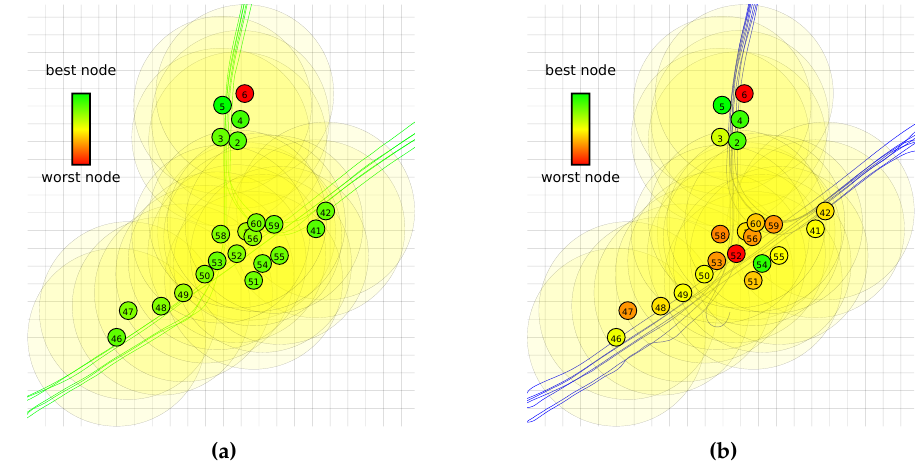
Figure 8. Spatial visualisations of performance of the network when a node is used for the offline phase for the QUEST algorithm. The grid size is 20 m. Colors are assigned on a linear relative scale from red for the worst performing node to green for the best performing node. ( a ) AAV vehicles; ( b ) DW vehicles.